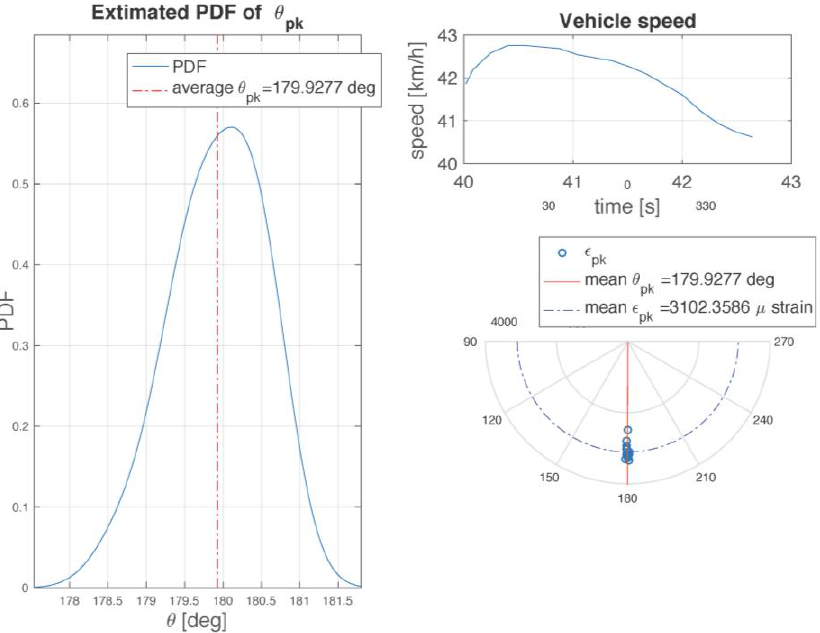
Figure 25. PDF and polar plot of strain peak angular position and plot of local speed over time